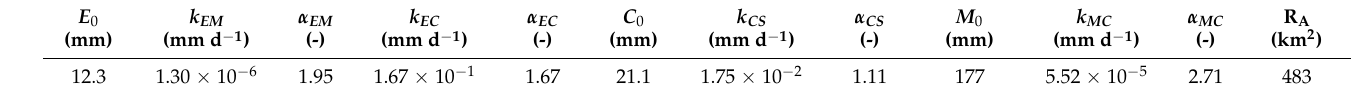
Table 1. Optimized parameters obtained over the calibration